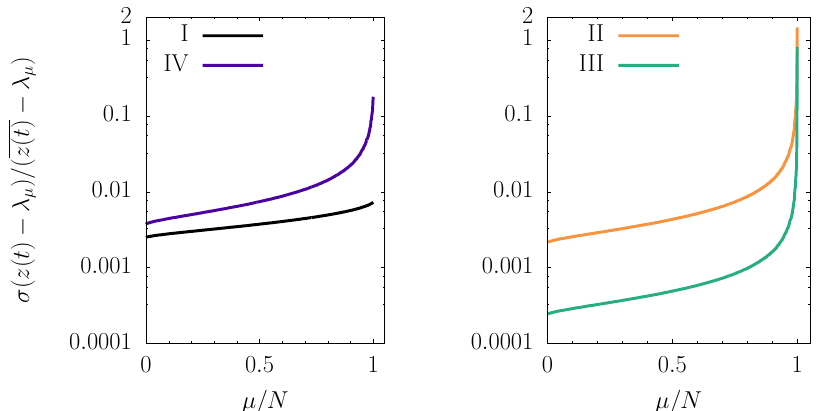
(phase III), and 0